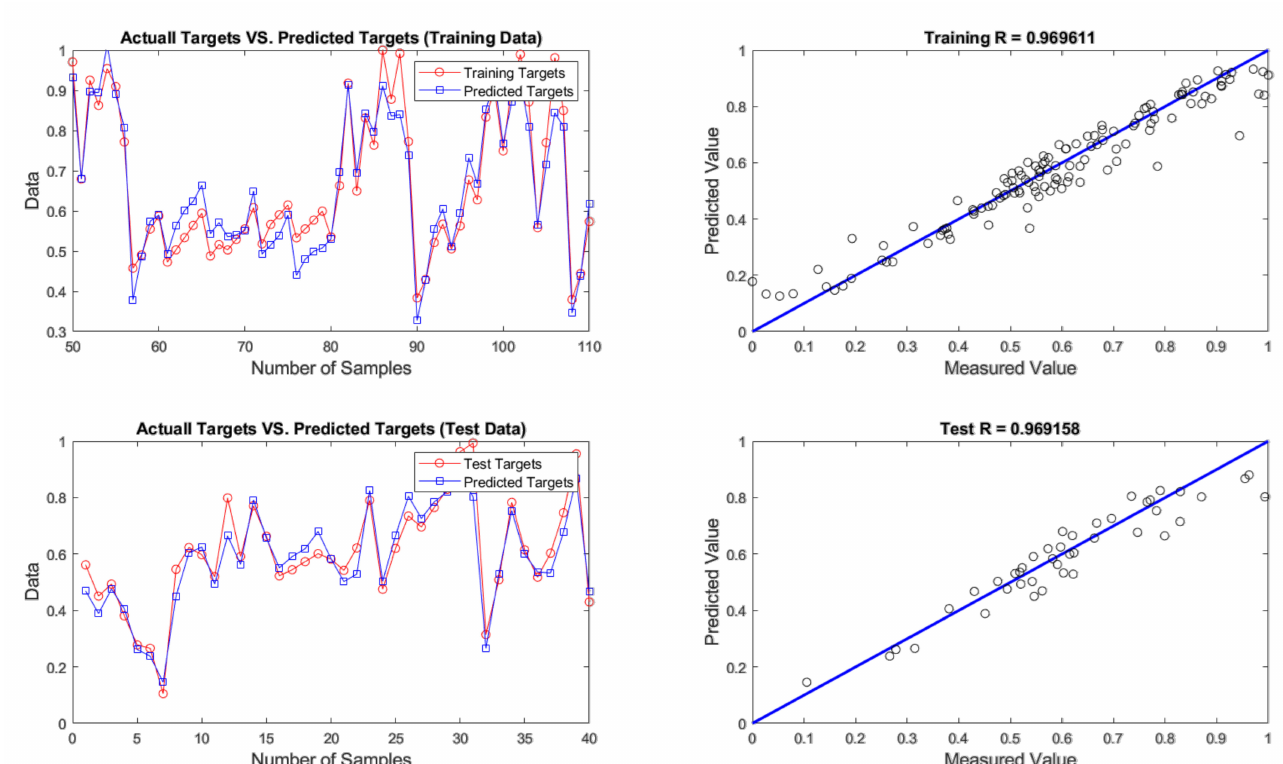
Figure 16. Results of training and testing data for predicting chromium removal using firefly algorithm.